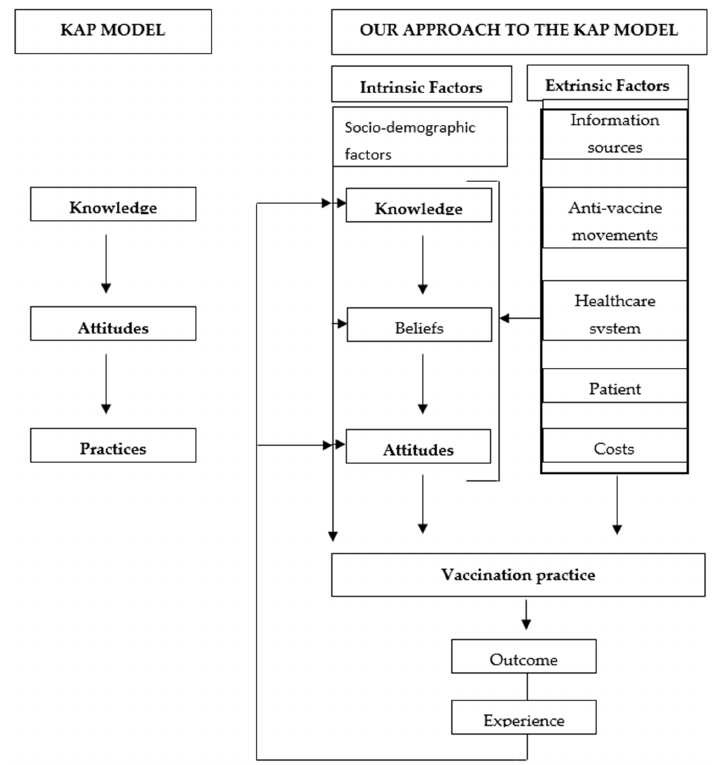
Figure 2. Theoretical framework of the influence of and interconnection among factors that influence vaccination practices (based on A. Teixeira Rodrigues et al.’s model).